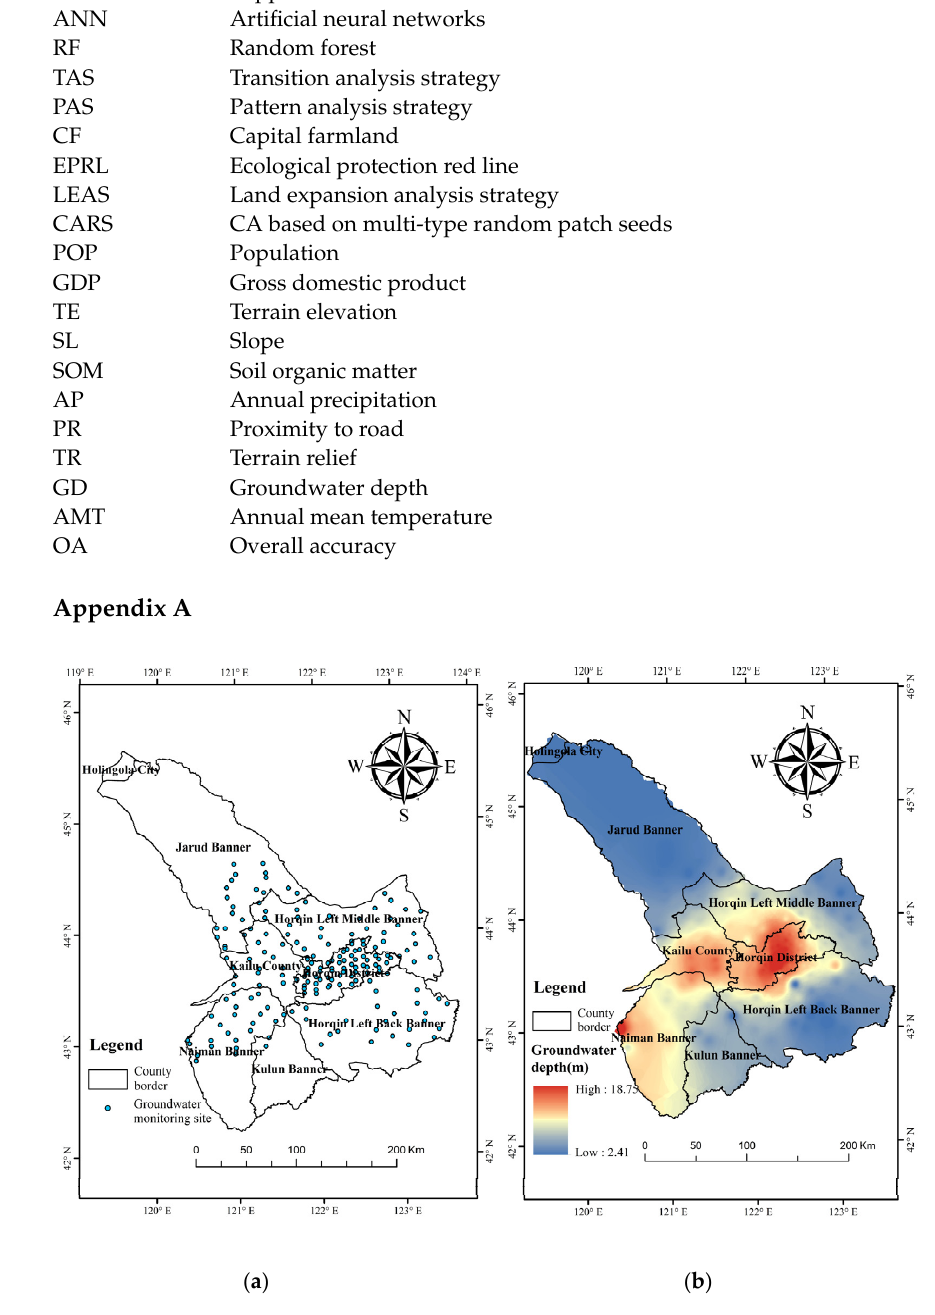
Figure A1. Maps of groundwater depth. ( a ) Groundwater monitoring site. ( b ) Results of spatial interpolation of groundwater depth.